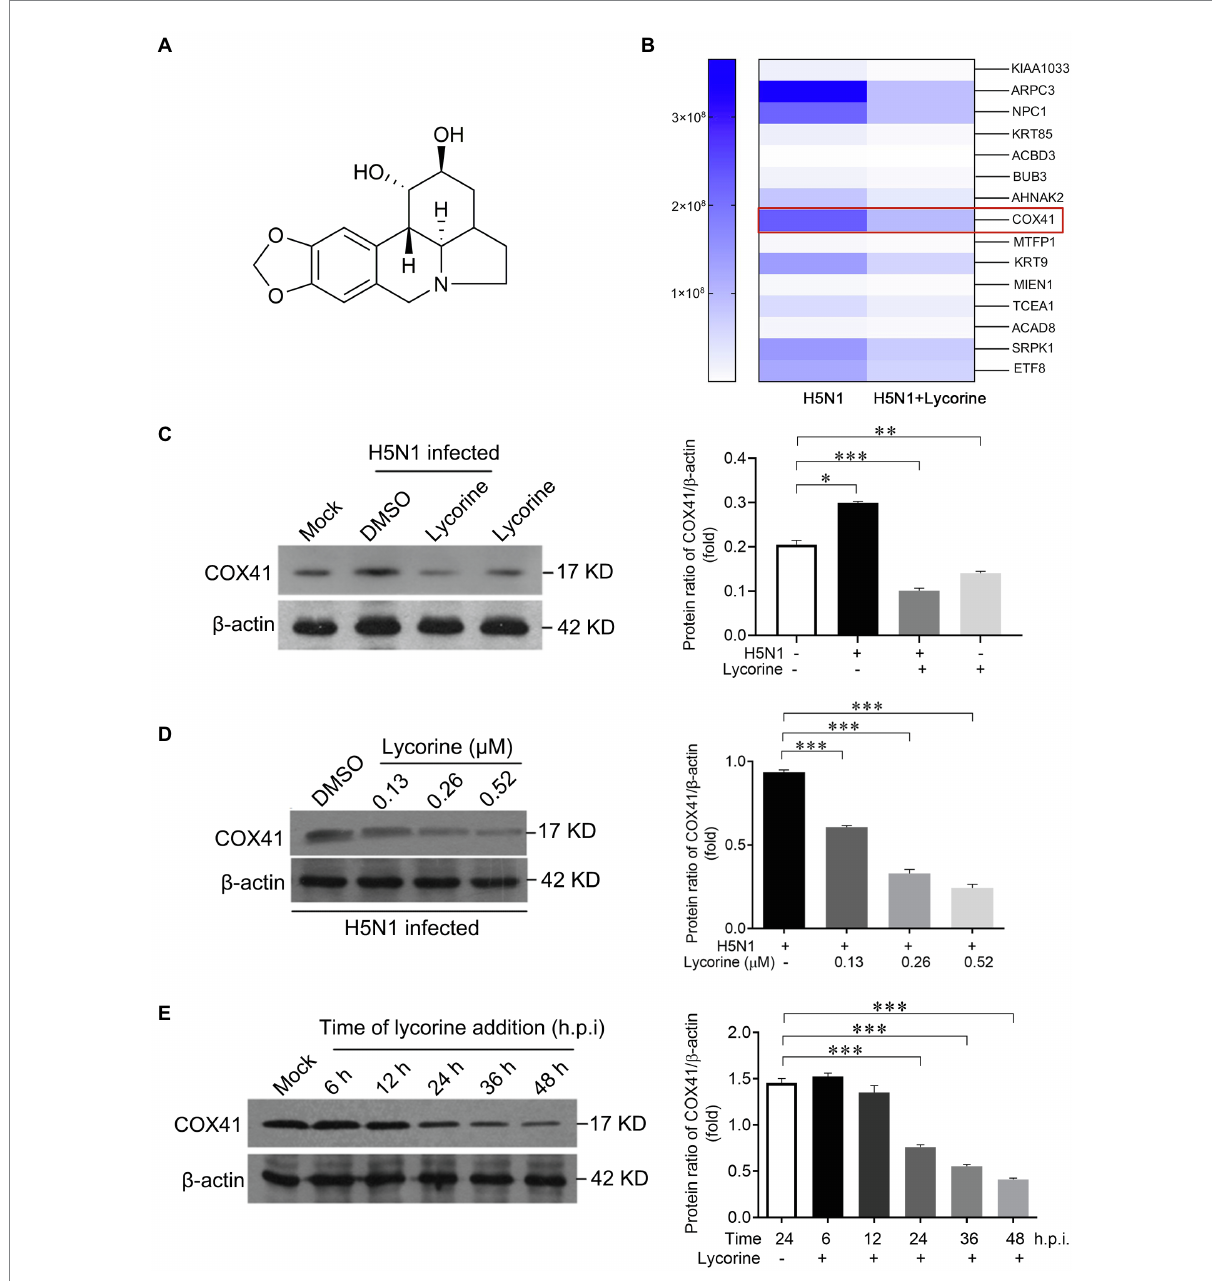
FIGURE 3 The expression of COX41 was inhibited by lycorine treatment in vitro . (A) Chemical structure of lycorine. (B) Quantitative proteomic analysis of H5N1-infected cells in responses to lycorine treatment. MDCK cells were infected with H5N1(MOI, 1) in the presence of lycorine (0.52 μ M) for 12 h. The upregulated proteins in H5N1-infected cells but downregulated proteins after lycorine treatment are presented as a heat map. (C) Western blot and quantitative analysis of COX41 levels in H5N1-infected MDCK cells. MDCK cells were infected with H5N1 (MOI, 0.01) and treated with DMSO or lycorine (0.52 μ M). The level of COX41 in cells was determined at 24 h after the viral infection. Data are mean ± s.d. ( n = 2 ~ 3). * p < 0.05, ** p < 0.01, *** p < 0.001 (D) Western blot analysis and quantitative analysis the expression of COX41 in H5N1-infected cells in the presence of DMSO or different concentrations of lycorine. Data are mean ± s.d. ( n = 2 ~ 3). *** p < 0.001. (E) Lycorine suppressed the expression of COX41. Plasmids expressing FLAG-tagged COX41 were transfected into HEK 293 T cells and incubated for 4 h, followed by treatment of lycorine (0.52 μ M). The cell lysates were harvested at 6, 12, 24, 36, and 48 h after transfection and analyzed by western blot assay. Data are mean ± s.d. ( n = 2 ~ 3). *** p <